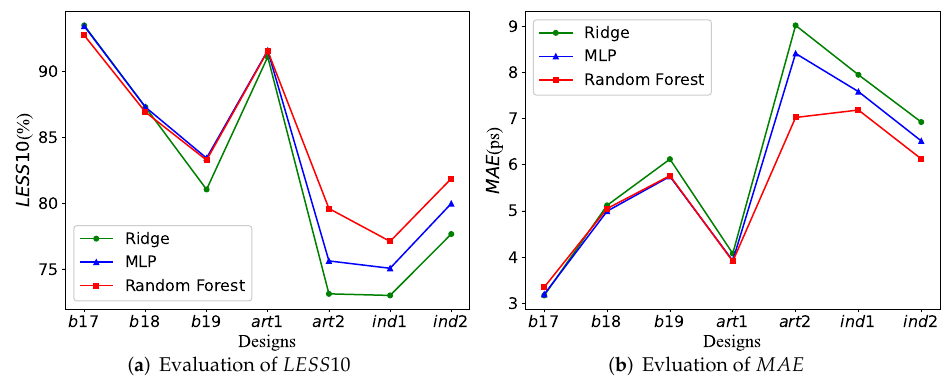
Figure 6. Performance evaluation of the three models. Subfigure ( a ) shows the evaluation of LESS 10 of three models on all designs. Subfigure ( b ) shows the evaluation of MAE of three models on all